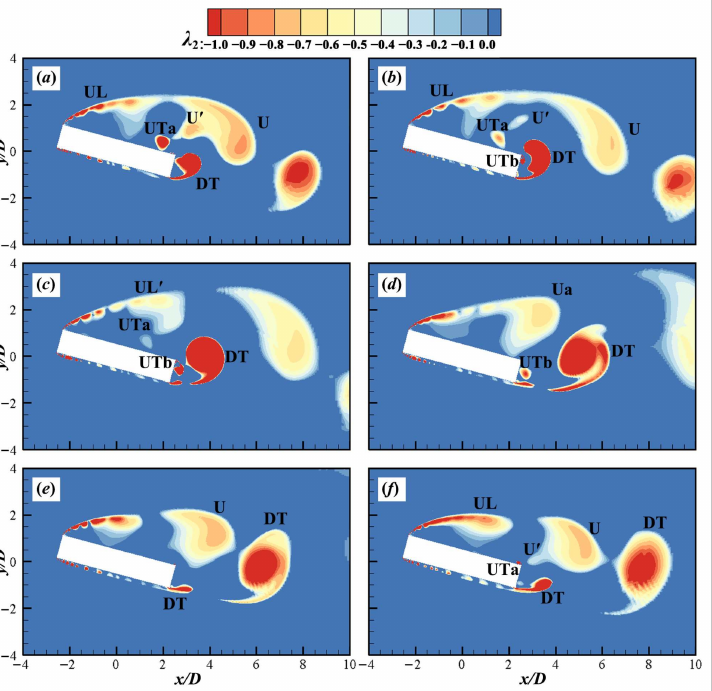
Figure 23. Vortex evolution within a vortex shedding period at α = 15 ◦ . ( a ) tU ∞ /D = 881.0, ( b ) tU ∞ /D = 884.0, ( c ) tU ∞ /D = 886.0, ( d ) tU ∞ /D = 891.0, ( e ) tU ∞ /D = 896.0, ( f ) tU ∞ /D = 899.0.